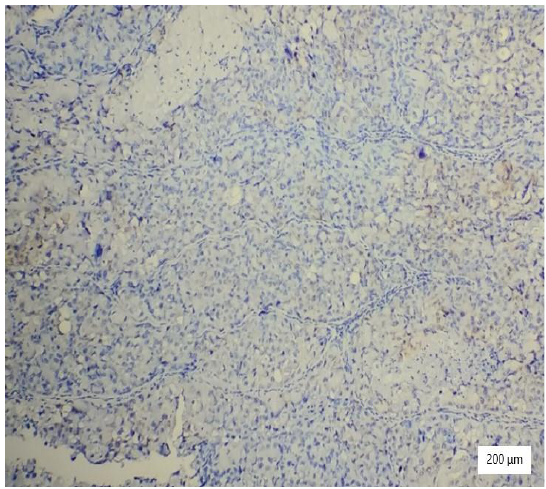
Figure 8. Ki 67 positivity in tumor cells (×100).